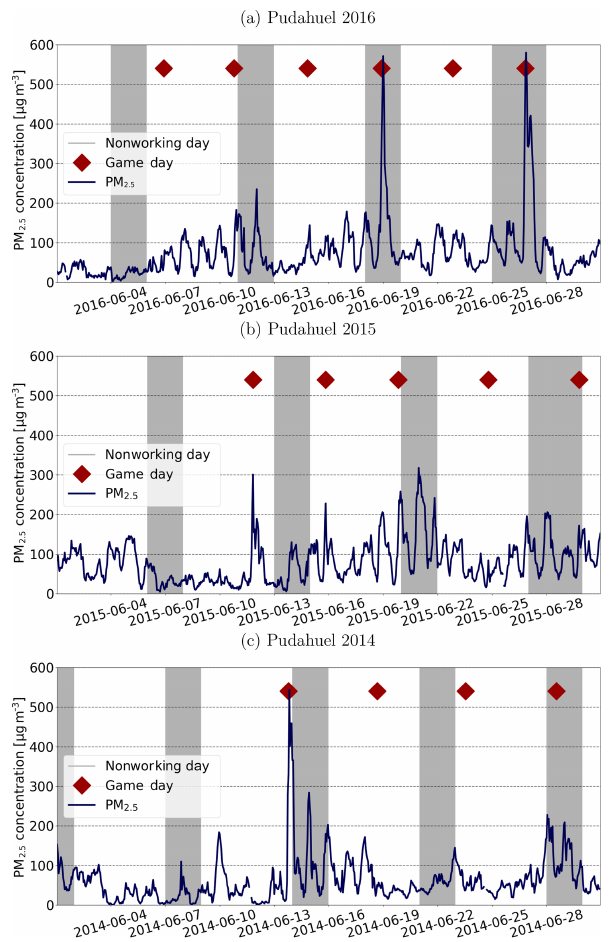
Figure 8. PM 2 . 5 peak events coincidence with soccer games. (a) Hourly PM 2 . 5 concentrations at Pudahuel monitoring station (solid blue line), kickoff hours of soccer games (red diamonds), and nonworking days (shaded gray areas) in June 2016. (b) Same as (a) for June 2015. (c) Same as (a) for June 2014. Dates are given in the format